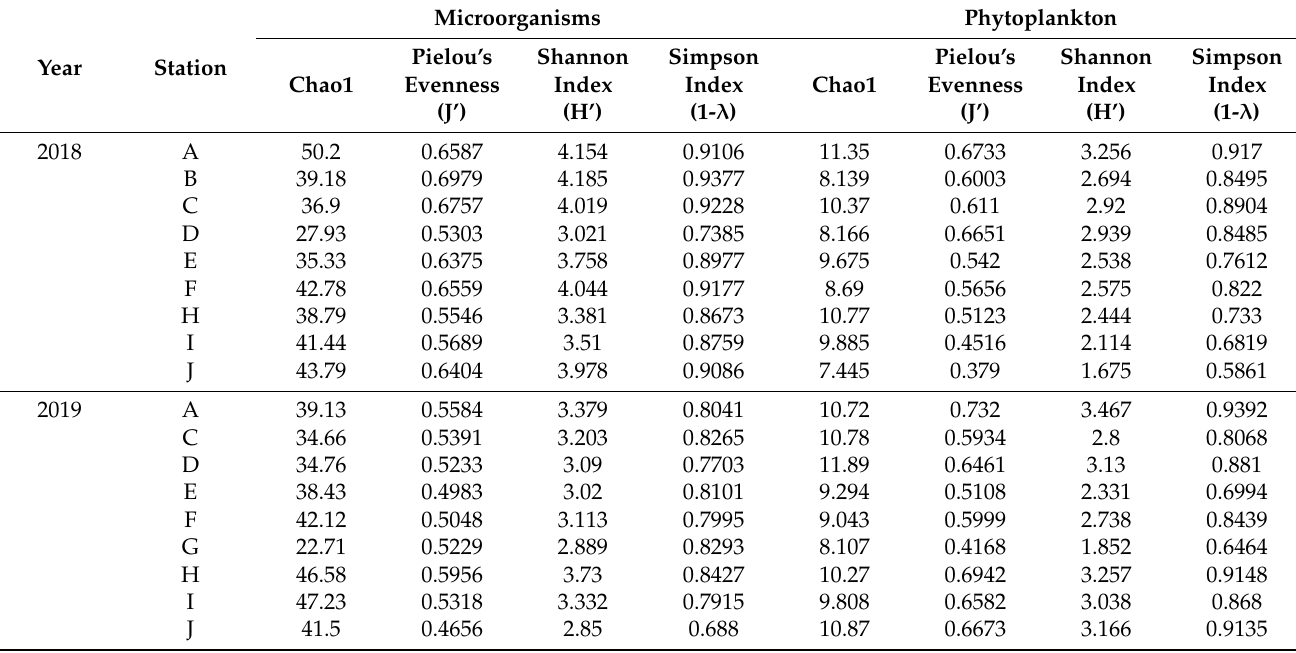
Figure 3. Microbial community structure of samples. Relative abundances of the dominant groups at the phylum level. Table 5. The diversity indices of microorganisms and